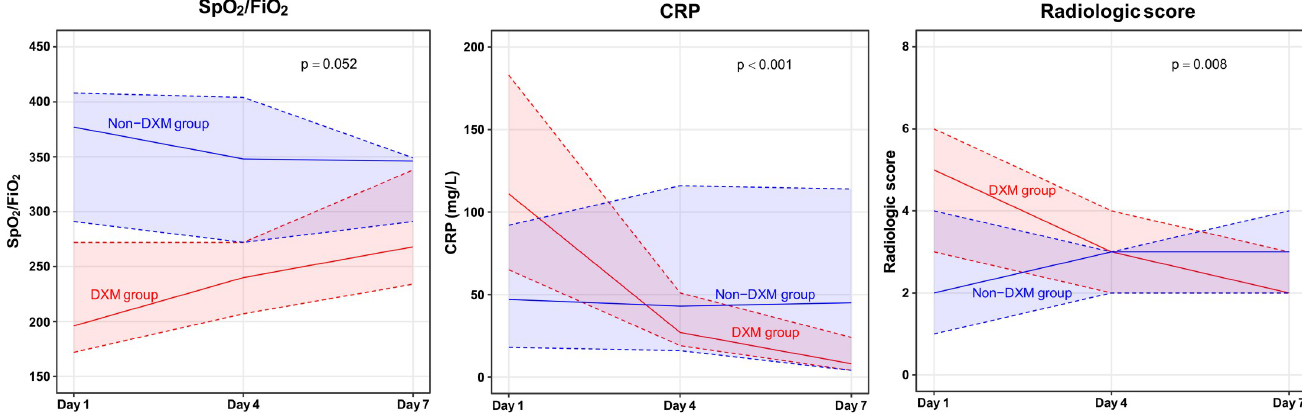
Fig 3. Clinical parameters during the 7-day study period. Solid lines represent the median values and the shaded areas bordered by dotted lines represent the upper and lower quartiles. CRP, C-reactive protein; DXM, dexamethasone; FiO 2 , fraction of inspired oxygen; SpO 2 , pulse oximetric saturation.